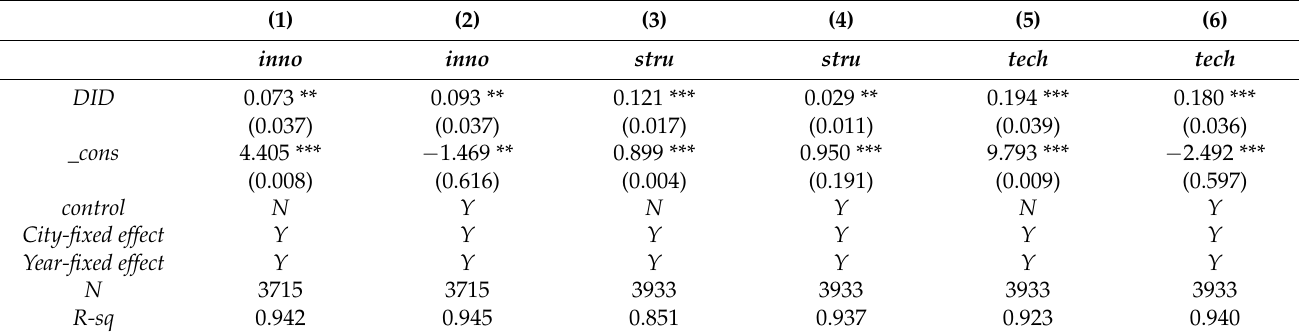
Table 10. Transmission Mechanism